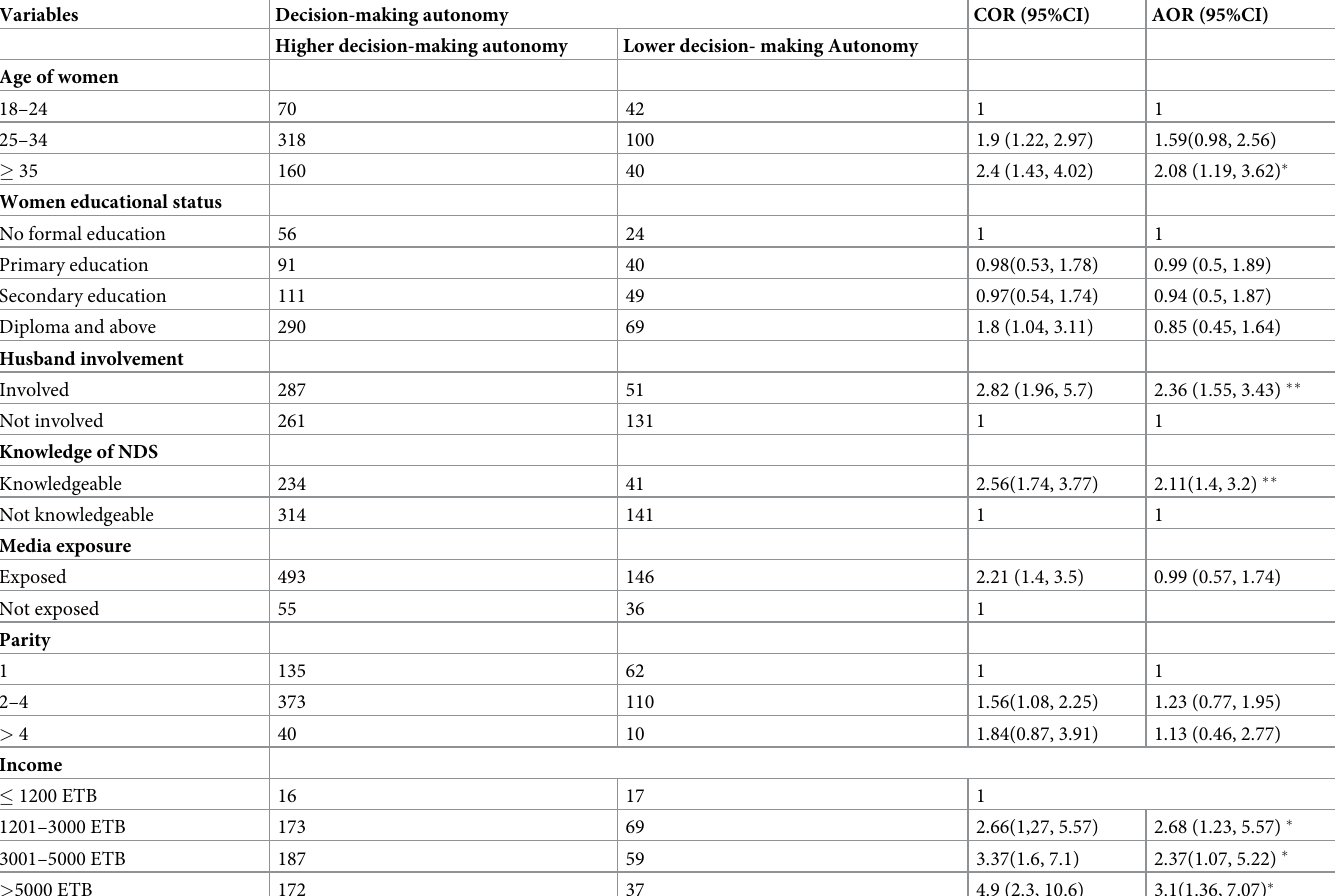
Table 4. Bivariable and multivariable logistic regression analysis of factors associated with women’s decision-making autonomy in Debretabor, Northwest Ethiopia, 2019 (n =